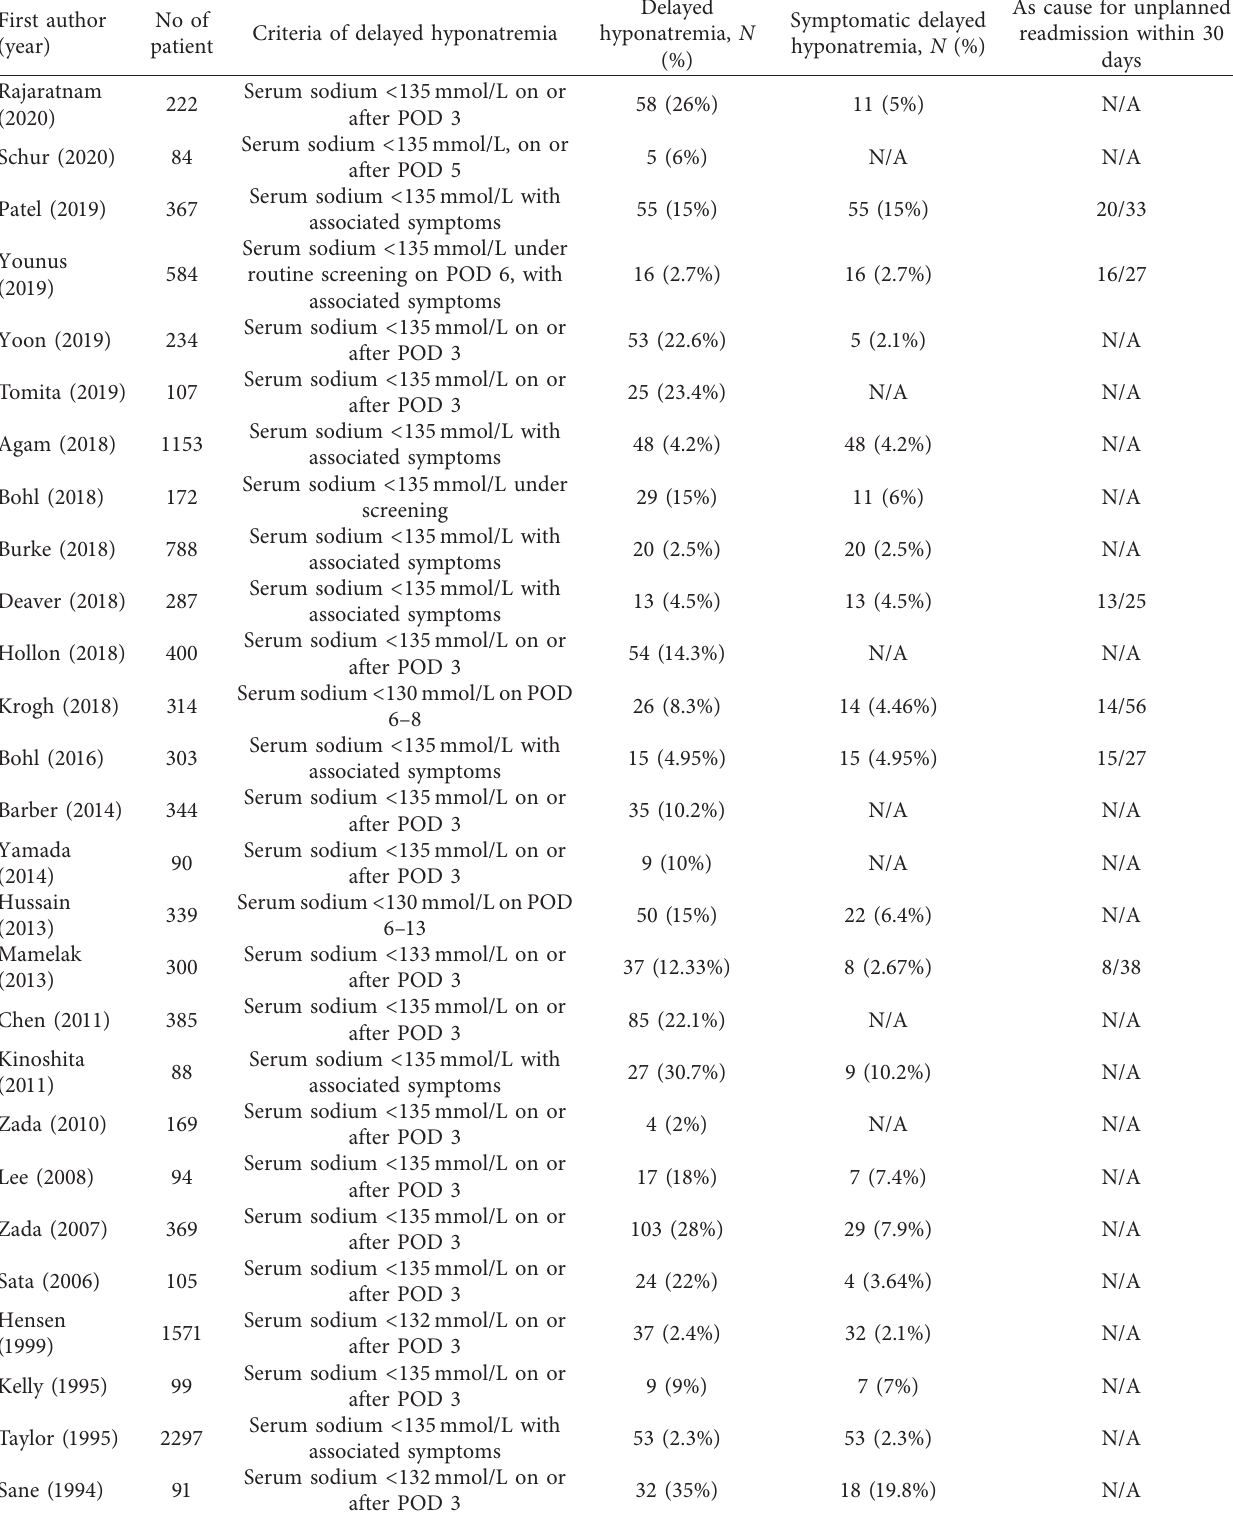
Table 2: The summary of